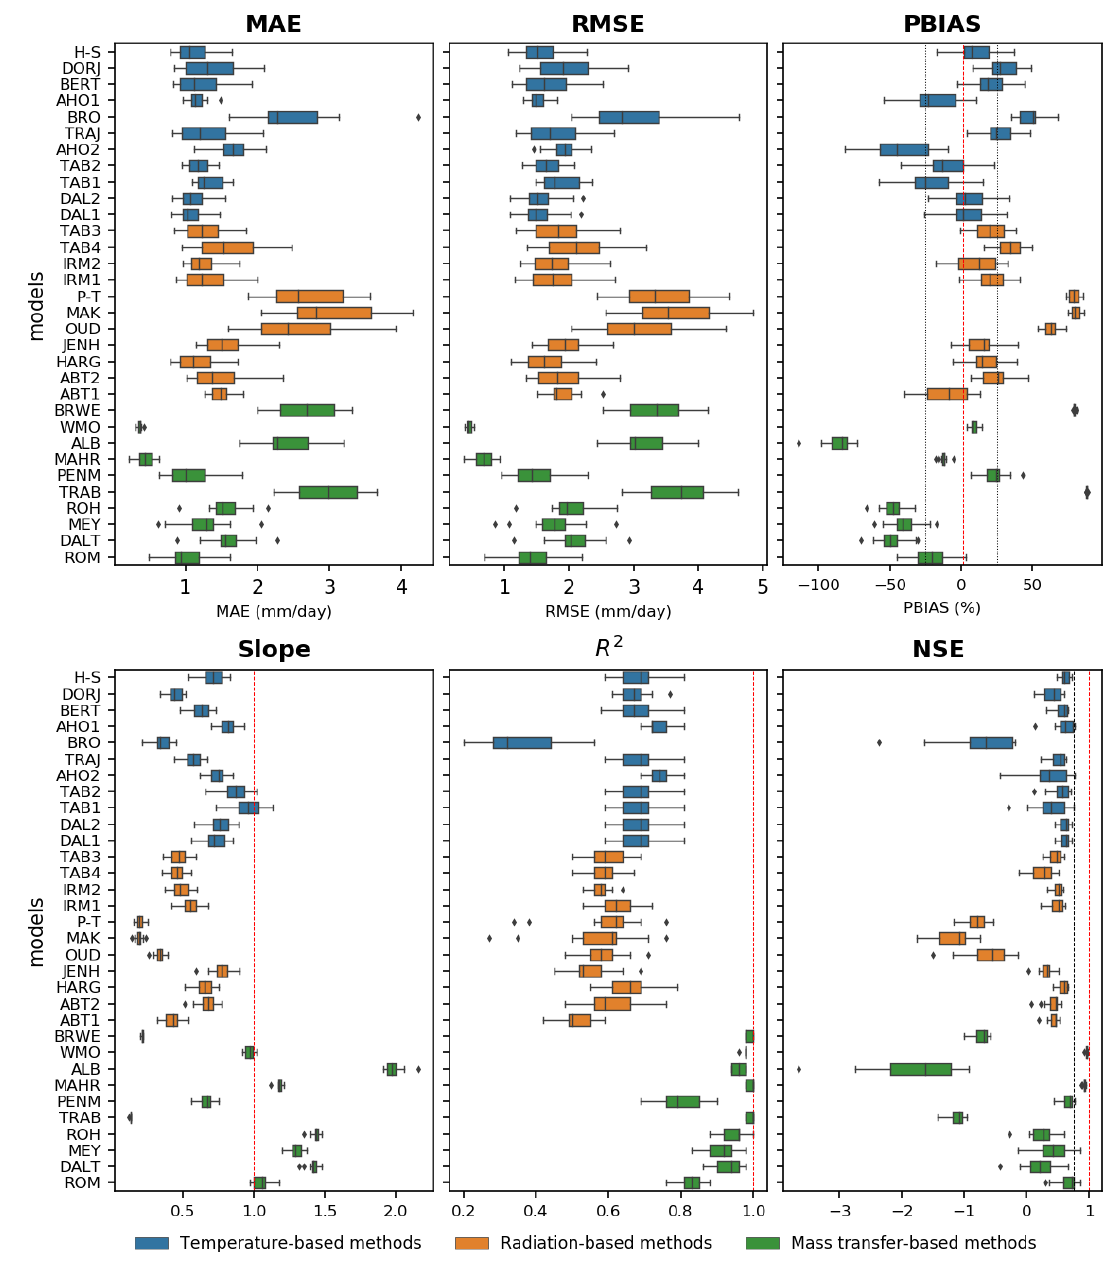
Figure 2. Daily performance of the simple ET 0 methods according to the selected evaluation metrics herein mean absolute errors ( MAE ), root mean square errors ( RMSE ), percentage bias ( PBIAS ), regression slope (Slope), coefficient of determination ( R 2 ), and Nash–Sutcliffe efficient ( NSE ). The red and black dash lines depict the optimum and threshold values of an evaluated metric, respectively.